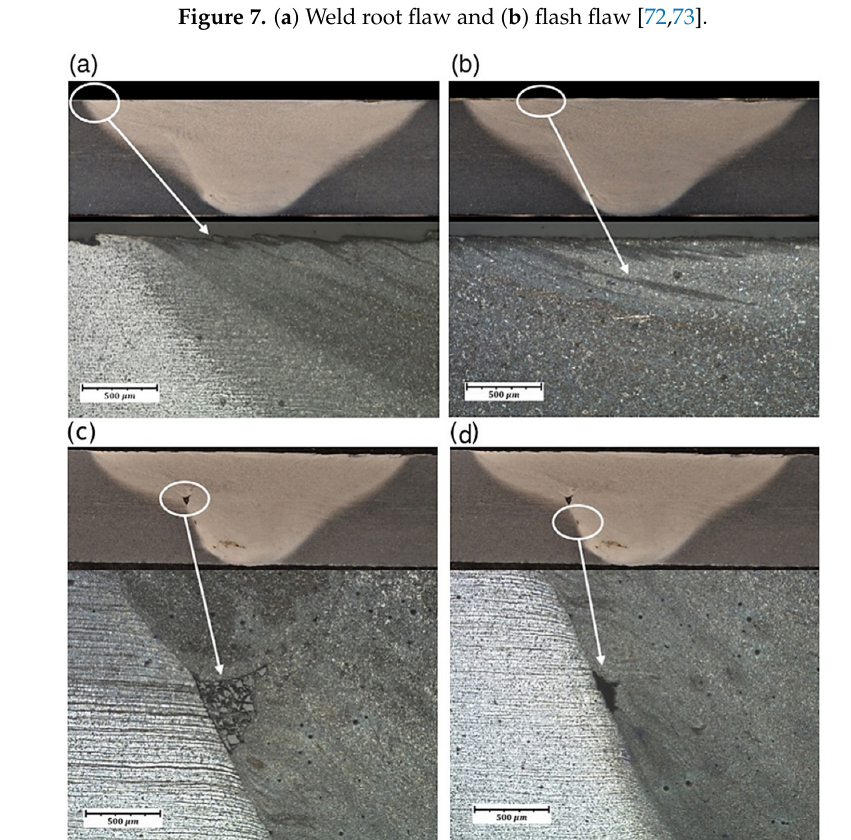
Figure 8. Incomplete fusion paths in weld: ( a ) at the advancing side of the weldment; ( b ) towards the middle of the weldment; ( c ) upper embedded flaw; and ( d ) connectivity flaw [73].